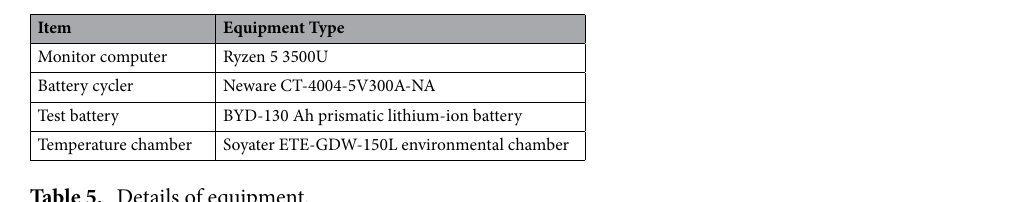
Table 5. Details of